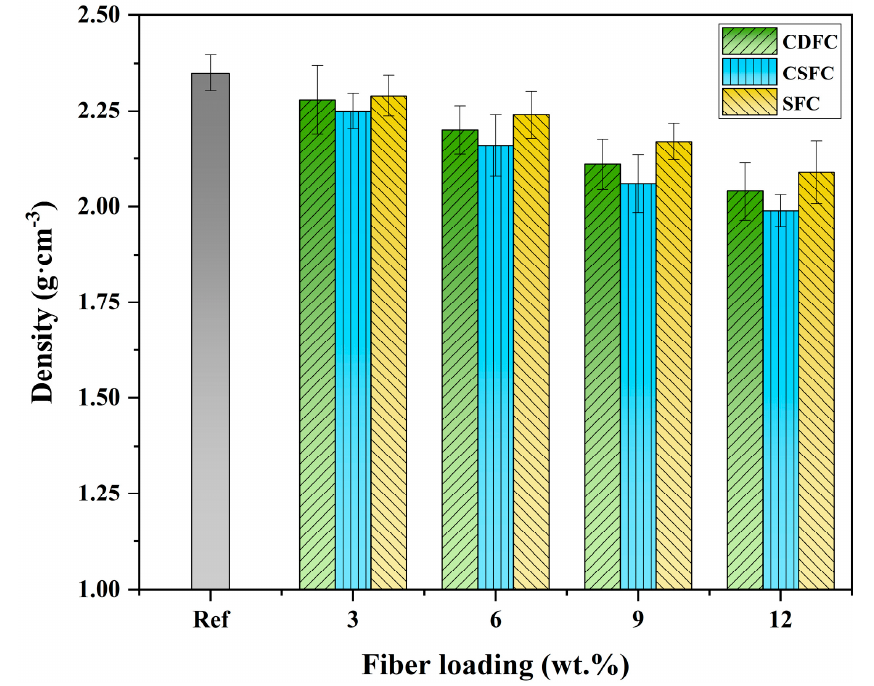
Figure 5. Density of the polymer composites Ref, CDFC, CSFC, and